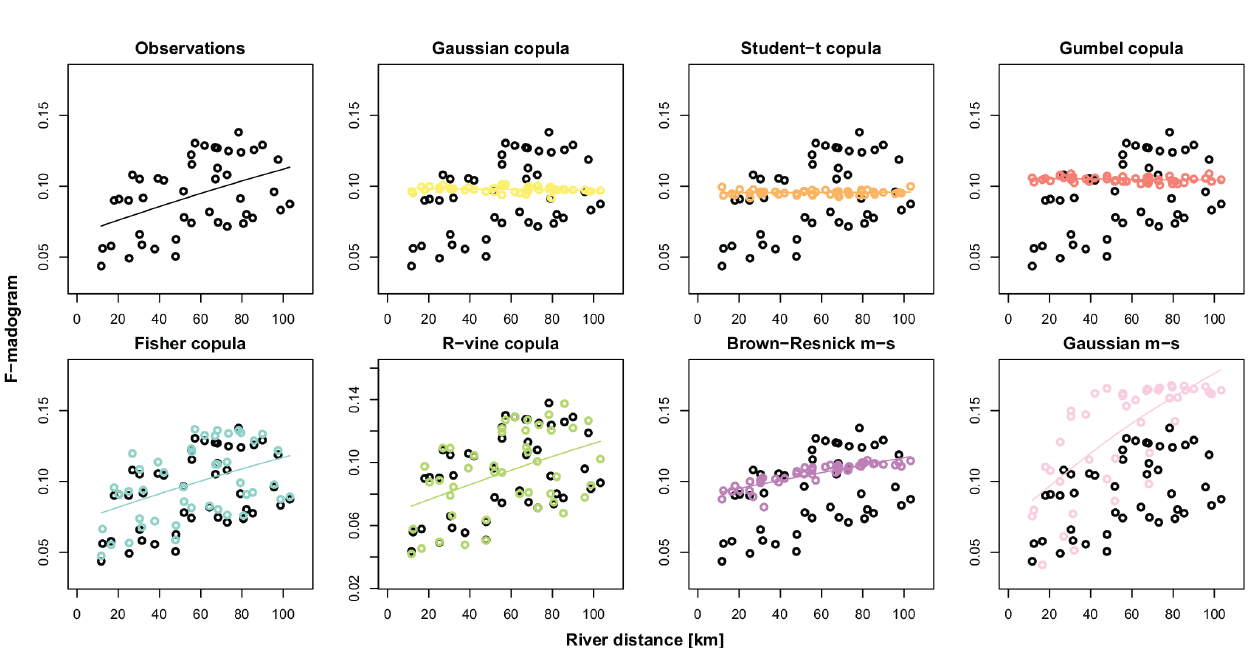
Figure 7. F-madograms of observations and samples simulated by different types of dependence models. A smoothed line was added to the data. Each simulated dataset is displayed in a separate panel to increase